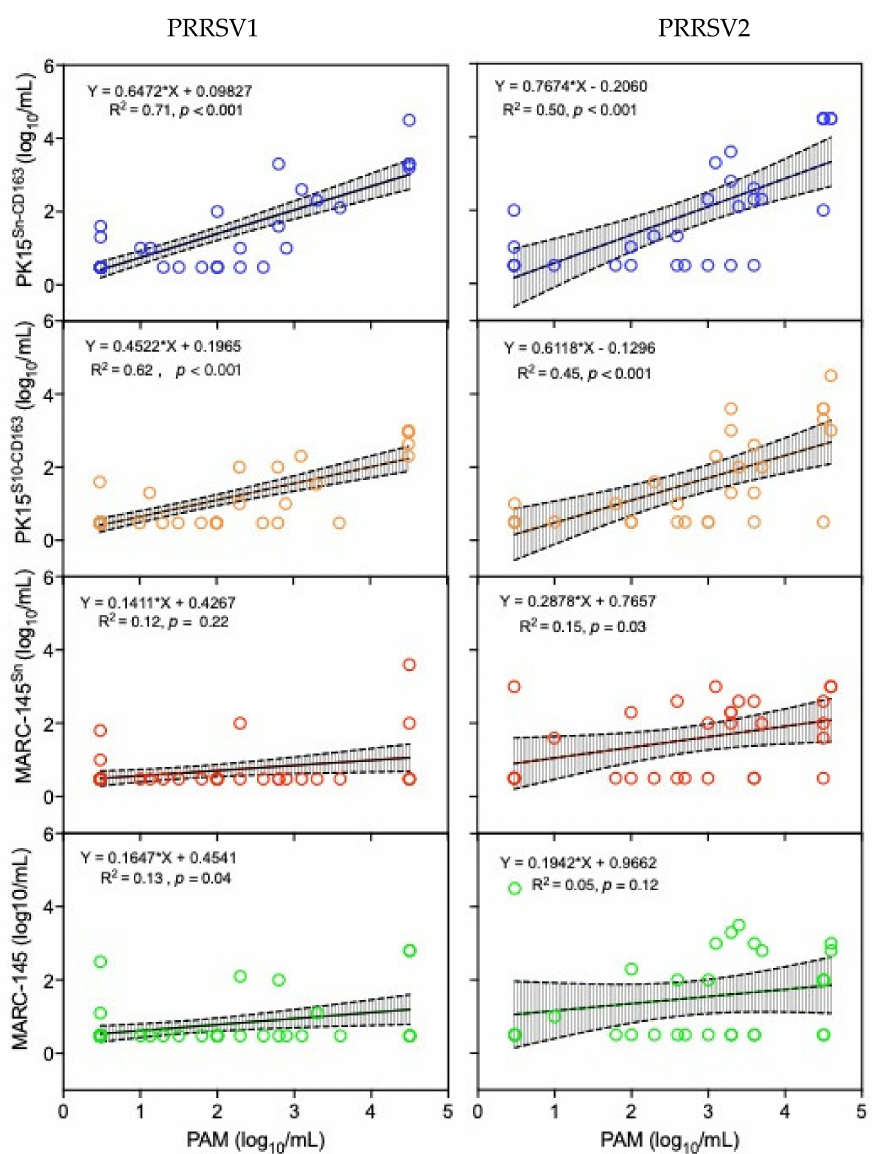
Figure 2. Correlation analysis of type 1 and type 2 PRRSV titration results obtained with PAM and one of the four continuous cell lines (PK15 Sn-CD163, PK15 S10-CD163, MARC-145 Sn, or MARC-145). Each bullet represents the virus titer obtained with PAM ( X -axis) versus the titer obtained with one of the four continuous cell lines (PK15 Sn-CD163 , PK15 S10-CD163 MARC-145 Sn , and MARC-145) ( Y -axis). The line of linear regression was generated and presented in the figure with a 95% confidence interval (CI 95%